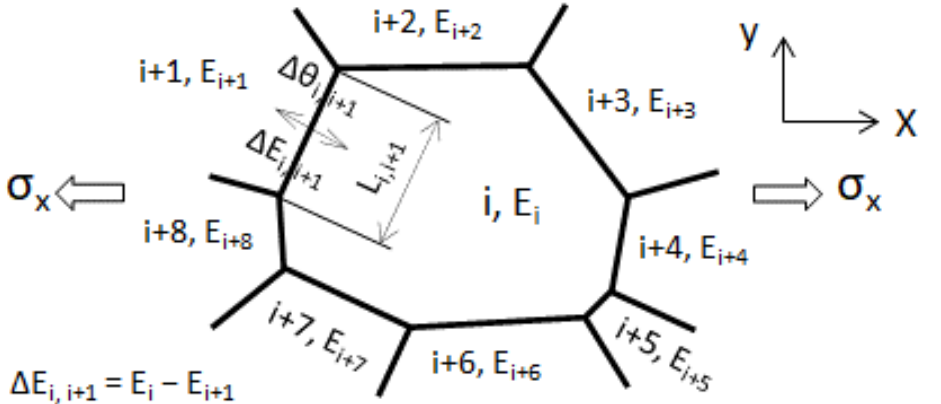
Figure 7. A diagram of a grain (numbered i ) with its adjacent grains (numbered i + 1 to i + 8). E, inherent Young’s modulus; Δ θ , misorientation angle between two adjacent grains; Δ E , difference in the inherent Young’s moduli between two adjacent grains; L, grain boundary length. Suffix, grain number.